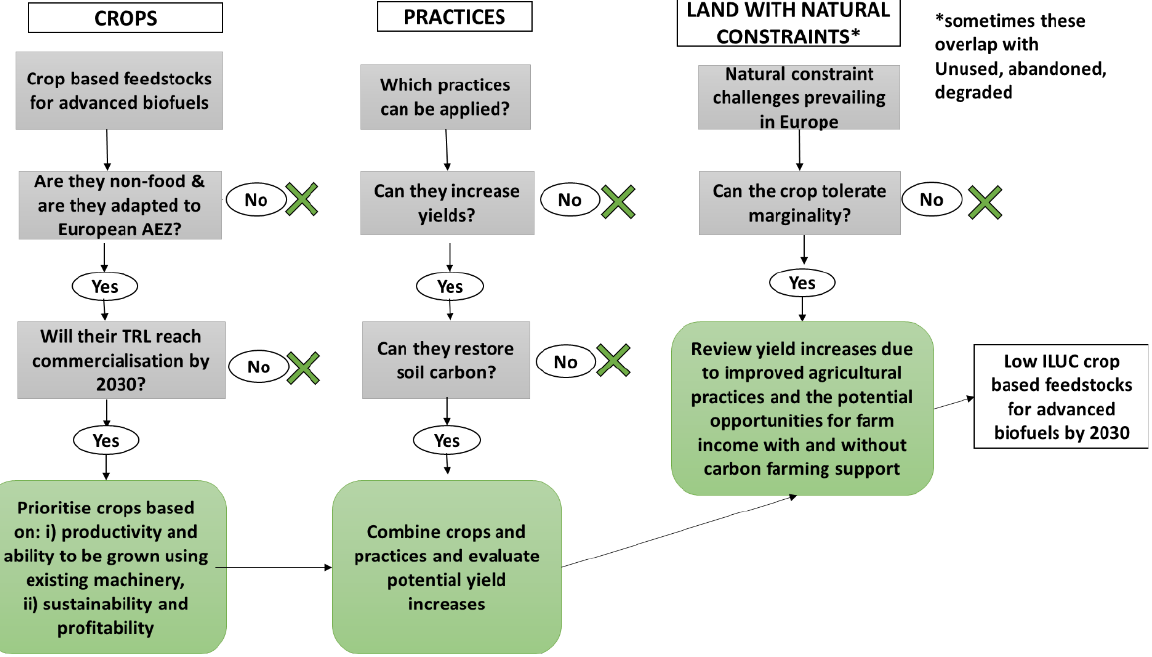
Figure 1. Methodological approach for the crop selection process.